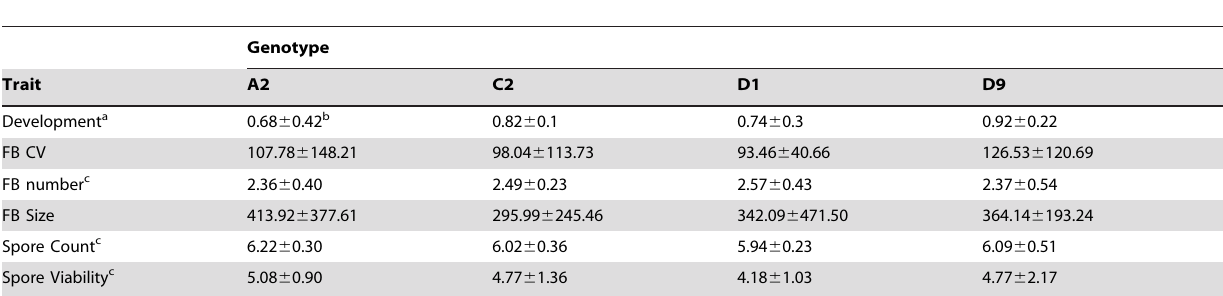
Table 2. Mutant trait means and 95% Confidence Intervals